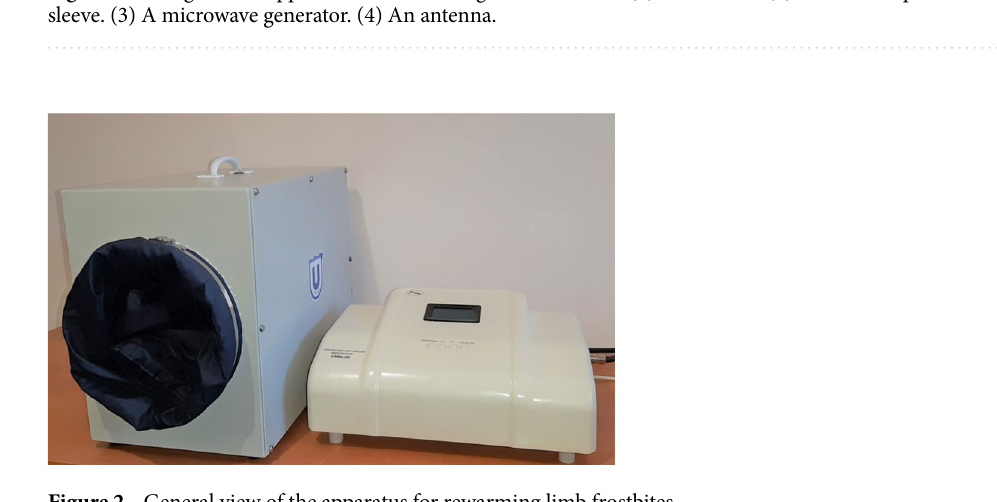
Figure 2. General view of the apparatus for rewarming limb